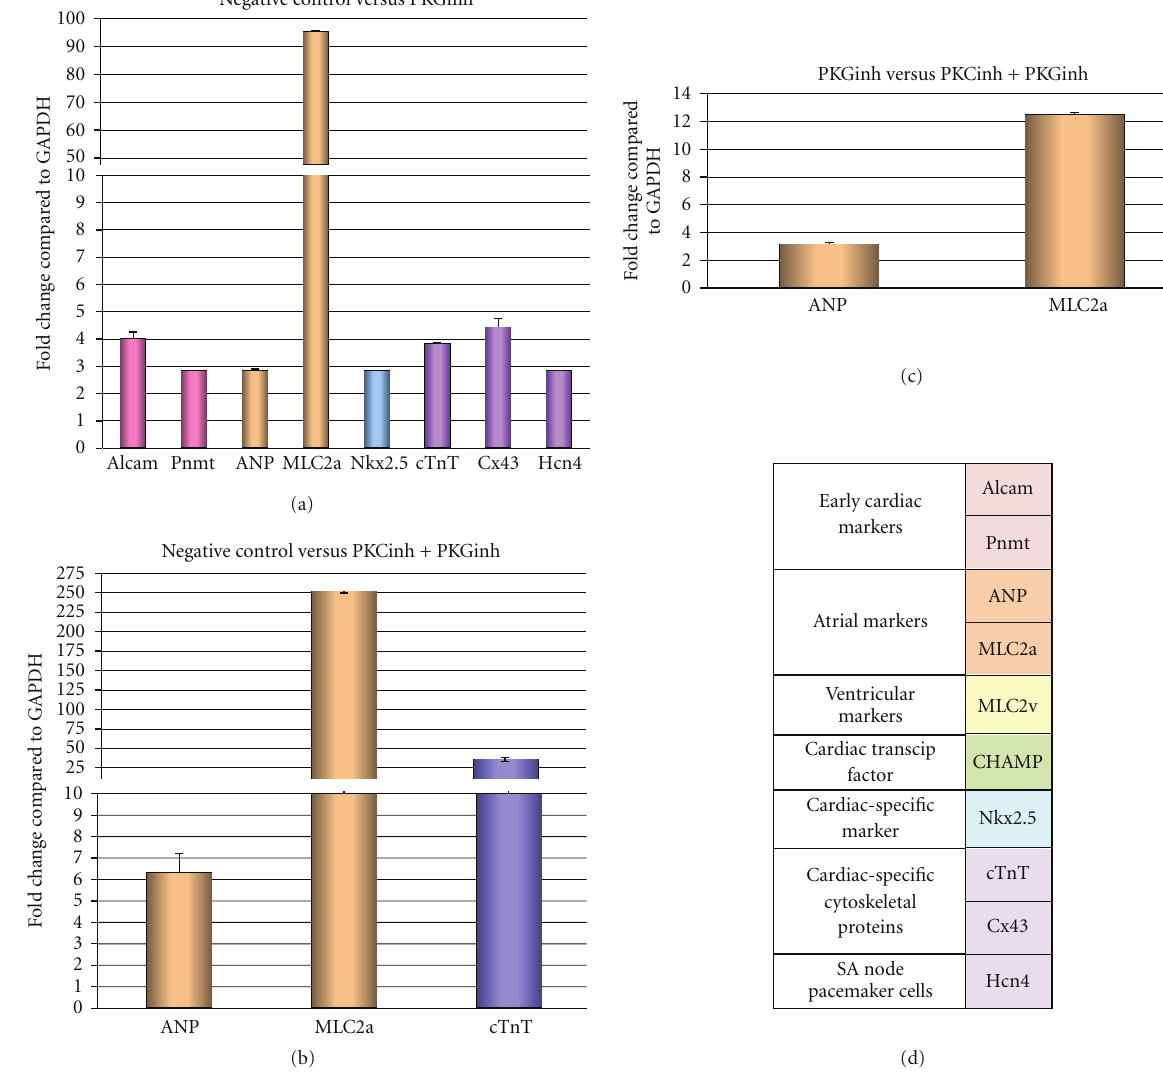
Figure 5: PKG in combination with PKC increases cardiac markers as shown by qRT-PCR. The time points in (a)–(c) are equivalent to Day 12 in Figures 3(a) and 3(b). (a) Negative control (untreated) versus PKG inhibitor: treatment of EBs with DT-3 resulted in increased early cardiac markers, atrial cardiac markers, the cardiac marker, Nkx2.5, as well as cardiac-specific cytoskeleton proteins when compared to negative control (untreated) EBs. (b) negative control versus combined treatment of PKC β inhibitor and DT-3: The combined treatment of PKC β and PKG inhibitors significantly upregulated atrial cardiac markers and the cardiac troponin T gene. (c) DT-3 Treatment versus combined treatment of PKC β inhibitor and DT-3: the combined treatment of PKC and PKG significantly upregulated both atrial markers, ANP, and MLC2a, when compared to treatment with PKG alone. (d) Table describing cardiac markers used for qRT-PCR. Graph color code = bars in